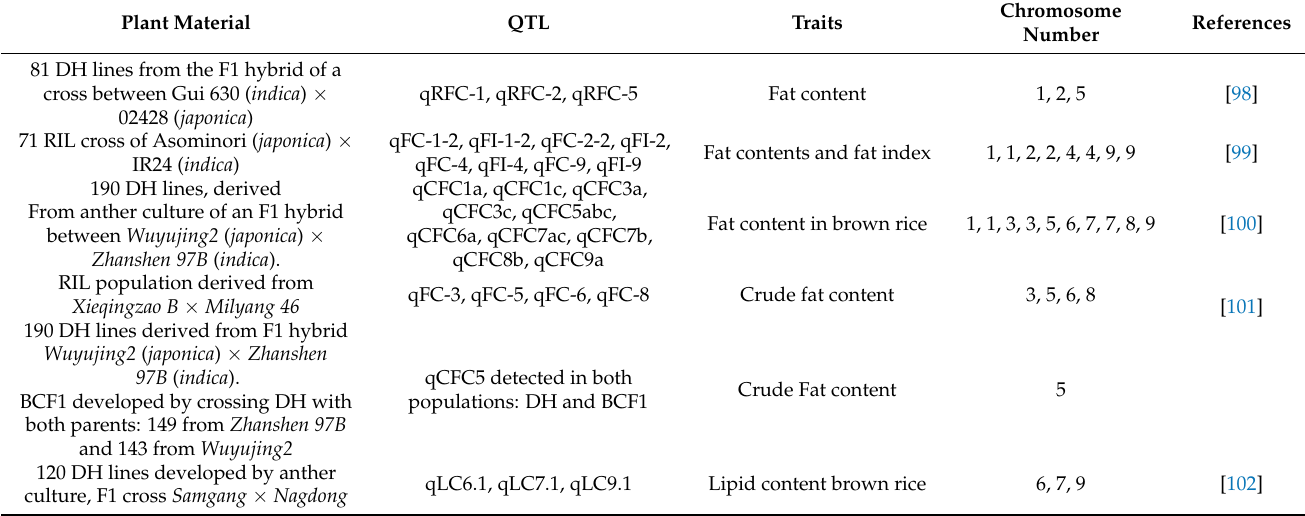
Figure 4. Distribution and illustration of starch and non-starch lipids. Source [94]. Table 5. Quantitative traits loci for grain lipids in rice.